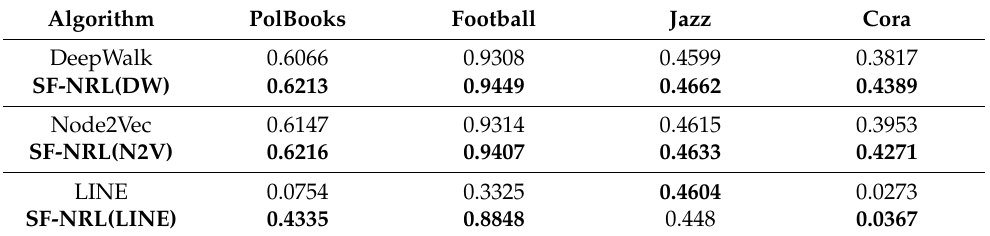
Table 2. NMI value between SF-NRL algorithm and the comparing